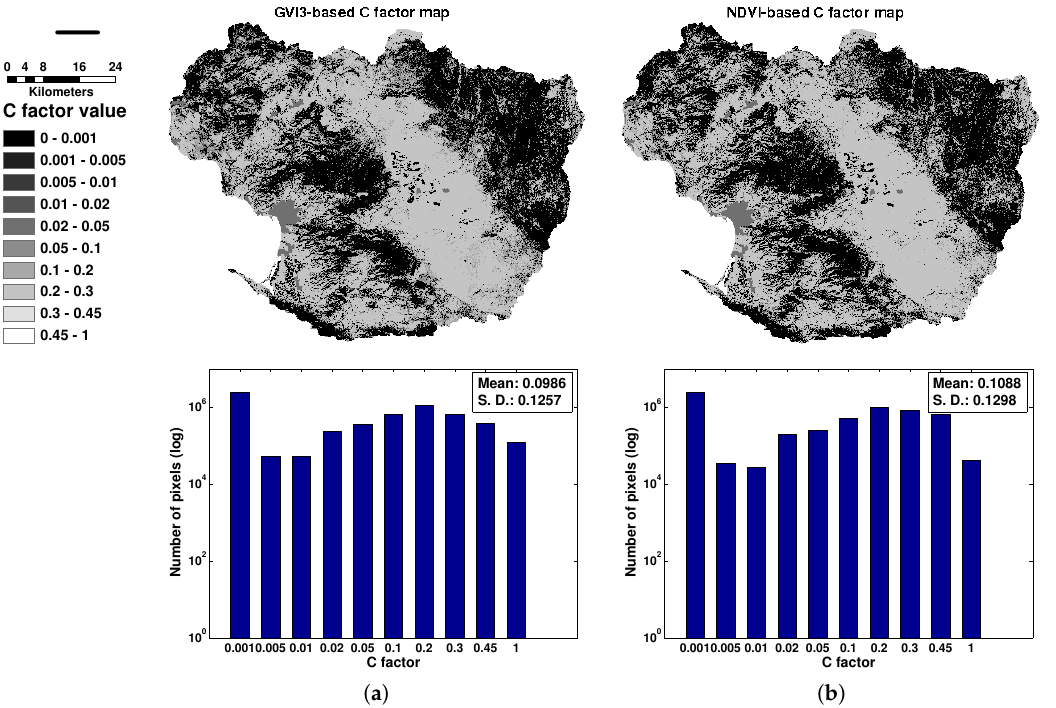
Figure 10. C factor maps produced by the best-performing conventional VIs using combined field data: ( a ) GVI3and ( b ) NDVI. The pixel histogram for each map is